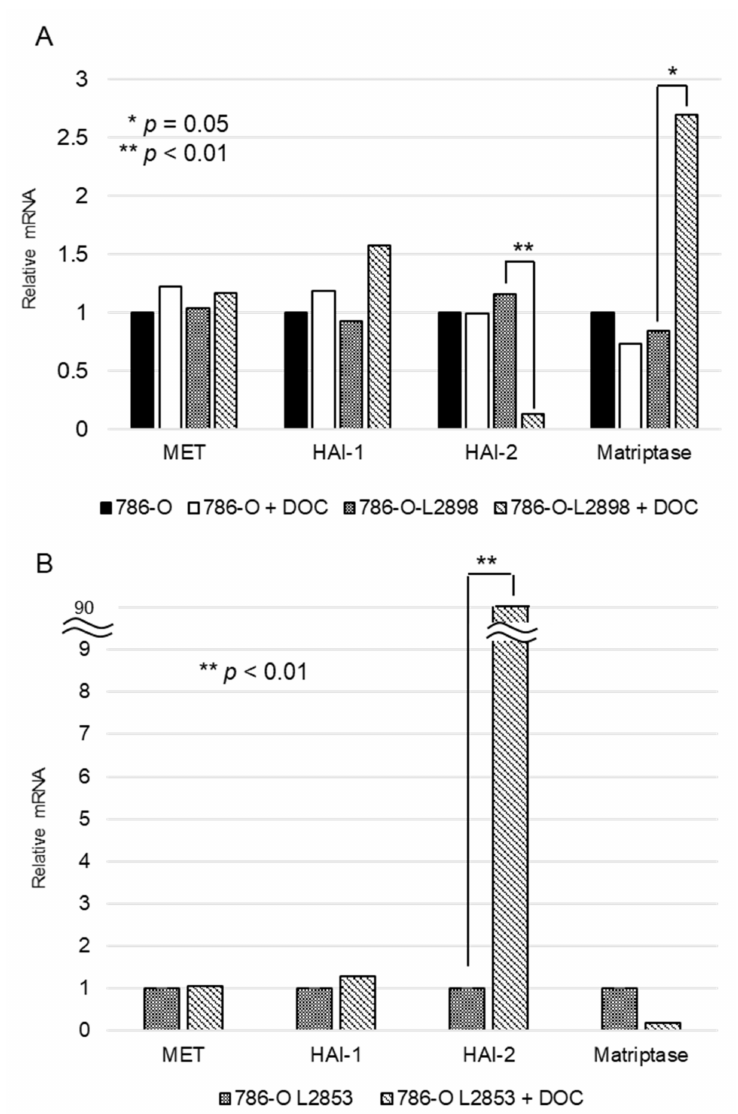
Figure 4. ( A ) Expression of HAI-2 was confirmed by RT-qPCR analyses in HAI-2-knockdown 786-O-Luc2 (786-O-L2898) with and without 0.5 µ g/mL of doxycycline (DOC). Effect of HAI-2-knockdown on expression of MET, HAI-1 and matriptase was also verified; ( B ) Expression of HAI-2, MET, HAI-1 and matriptase were confirmed in HAI-2-engineered expressed 786-O-Luc2 (786-O-L2853) cells with and without 0.5 µ g/mL of